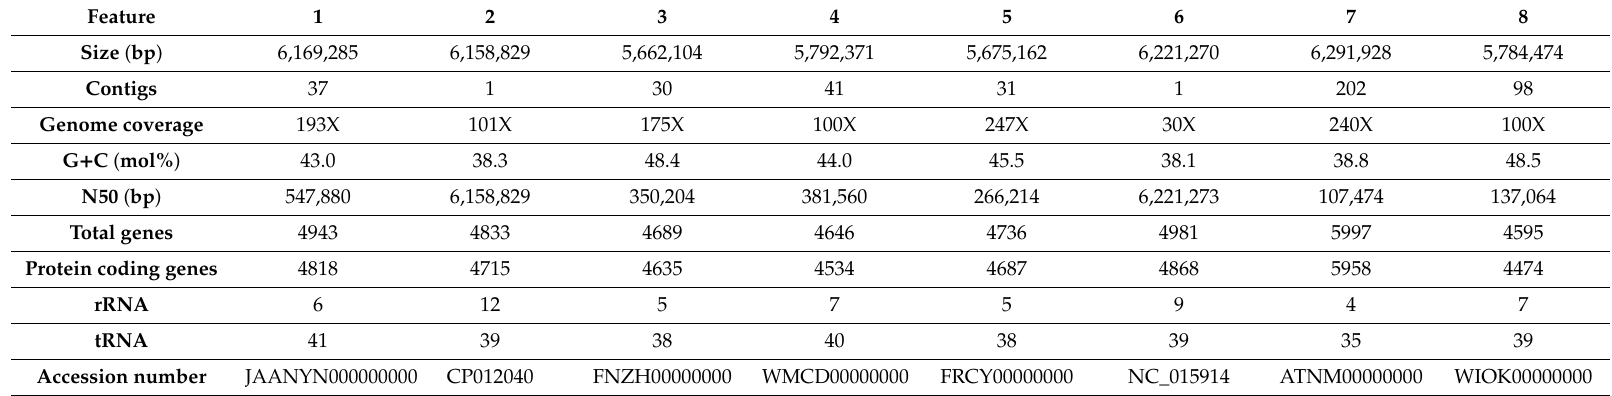
Table 1. General features of the genomes of the type strains of species of the genus Cyclobacterium